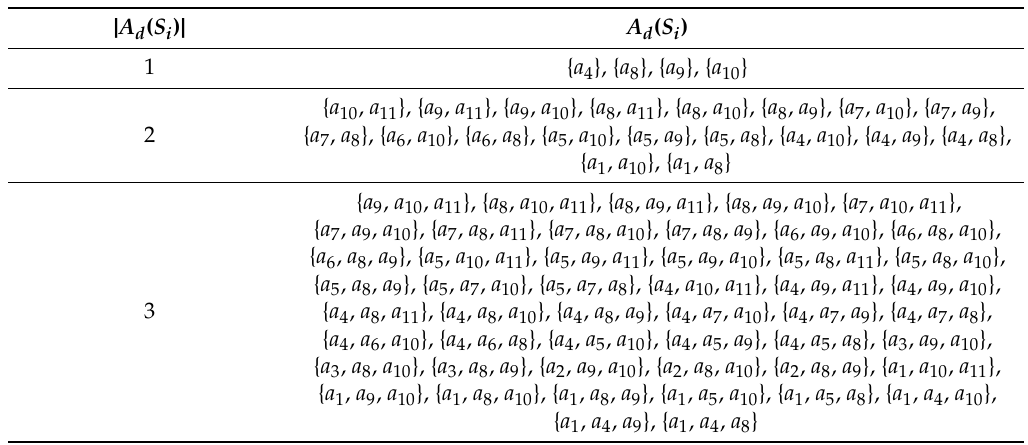
Table 10. I = 1 for arc sets with one, two and three arcs without recovery cost limit c .